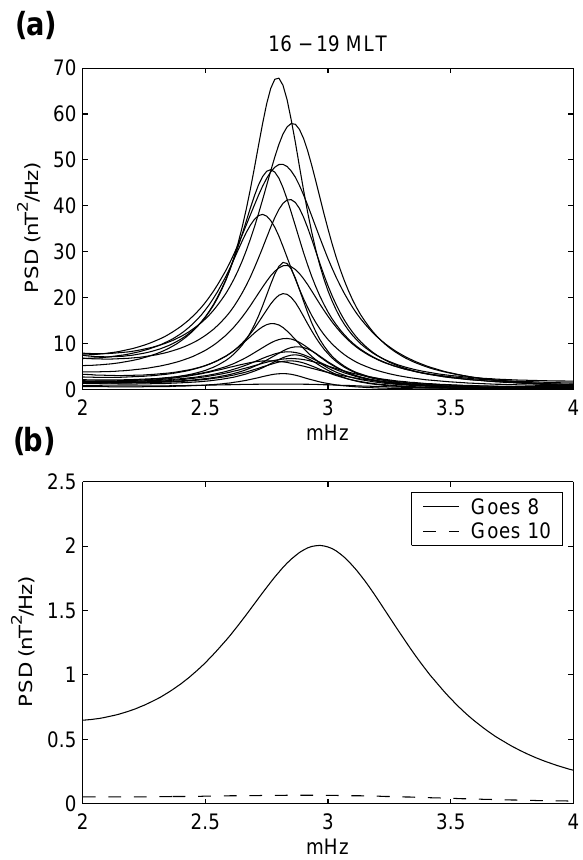
Fig. 8. ( a ) Spectral analysis for the time interval 16:00–16:20 UT for stations located in the dusk sector (16:00–19:00 MLT). ( b ) The same for Goes 8 and Goes